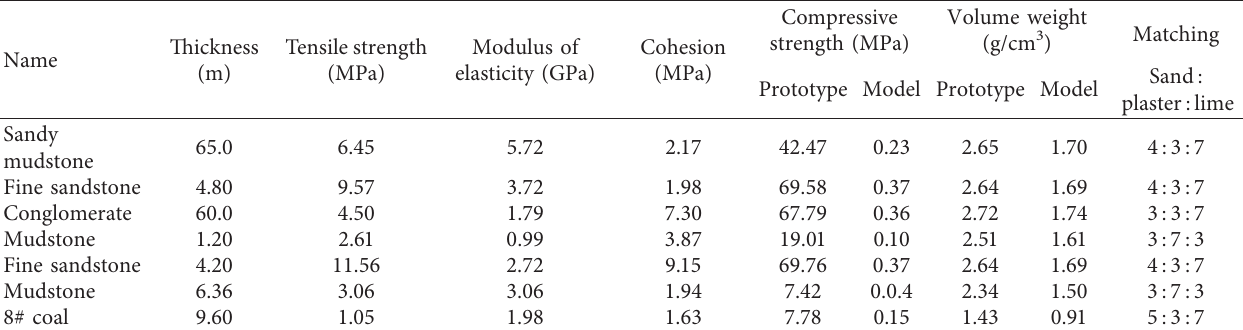
Table 1: Physical-mechanical parameters and ratio of coal rock in the model.